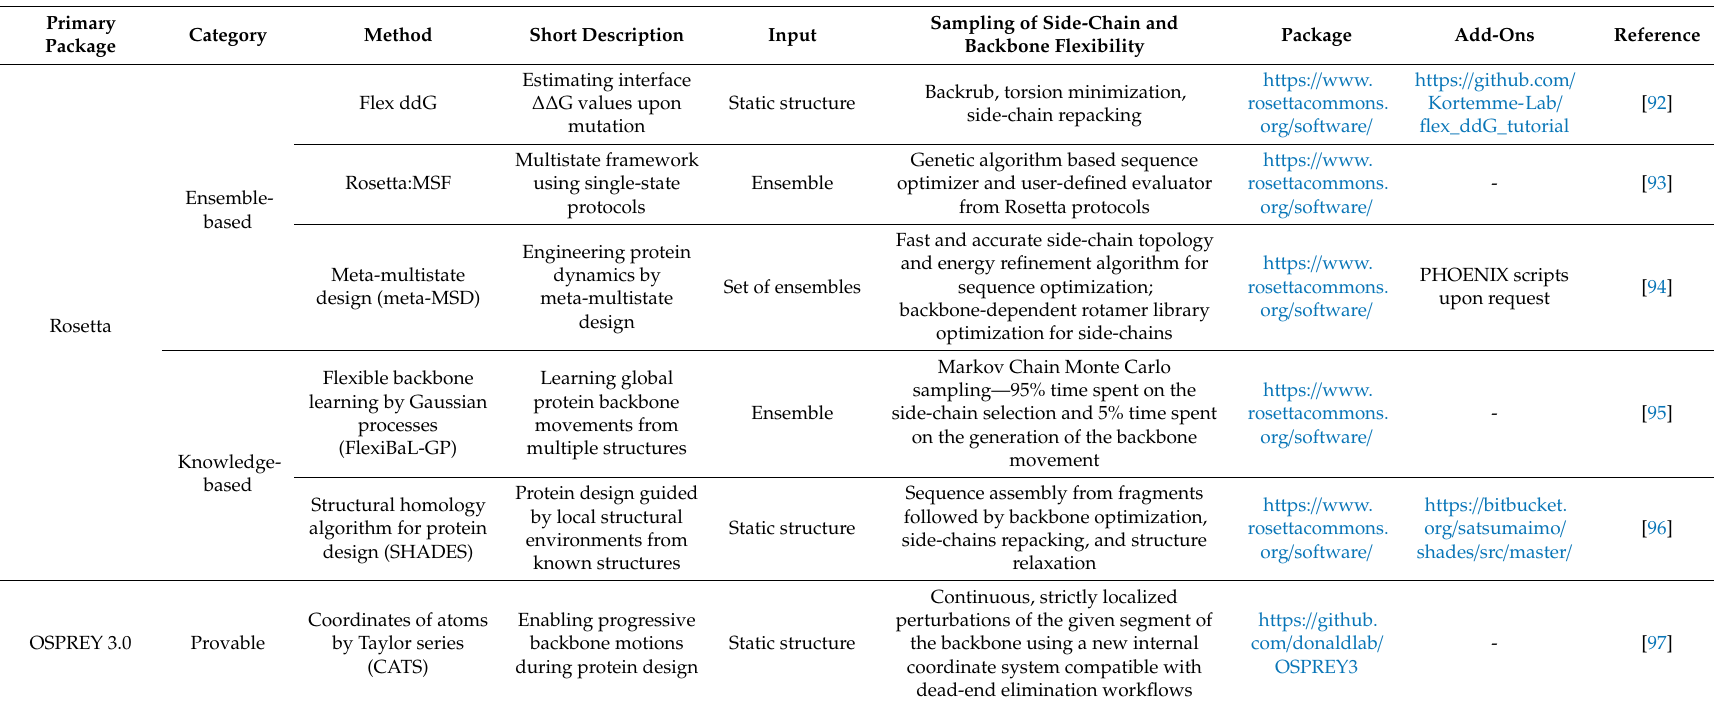
Table 2. Computational protocols implementing protein flexibility for protein design and